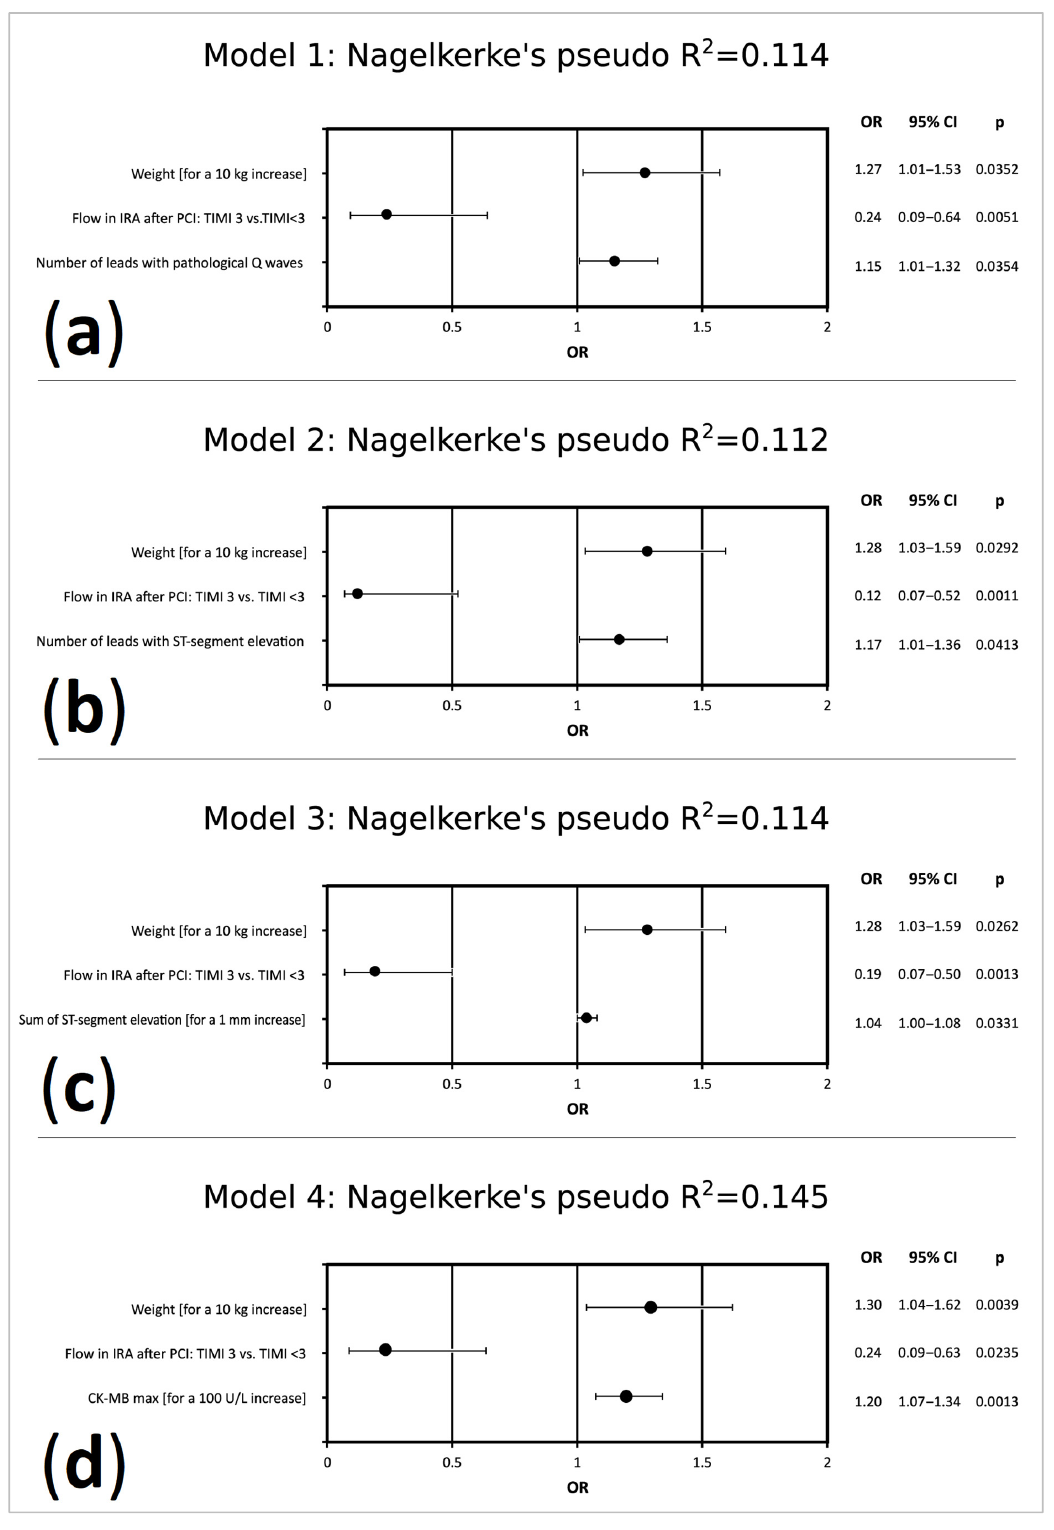
Figure 3. Predictors of LVR 6 months after STEMI in multivariate logistic regression models. Models ( a – c ) were created by adding a single electrocardiographic variable ( a )—number of leads with pathological Q waves, ( b )—number of leads with ST-segment elevation, ( c )—sum of ST-segment elevation) to the demographic, clinical and angiographic data shown in Table 1. In model ( d ), biochemical data from Table 1 were also included. CI, confidence interval; CK-MB max , maximal activity of creatinine kinase MB isoenzyme; IRA, infarct-related artery; LVR, left ventricular remodeling; OR, odds ratio; STEMI, ST-segment elevation myocardial infarction; TIMI, Thrombolysis in Myocardial Infarction